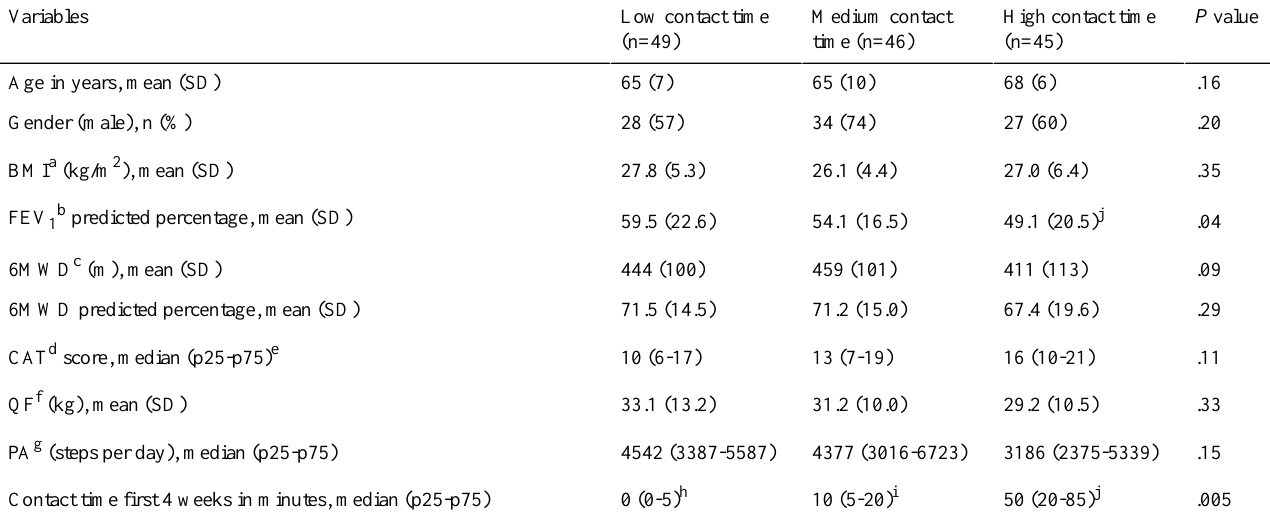
Table 3. Patient baseline characteristics according to the total contact time (only including patients with valid PA measurement; n=140); data are expressed as mean (SD) unless stated otherwise. P value indicates differences between the 3 contact time groups.